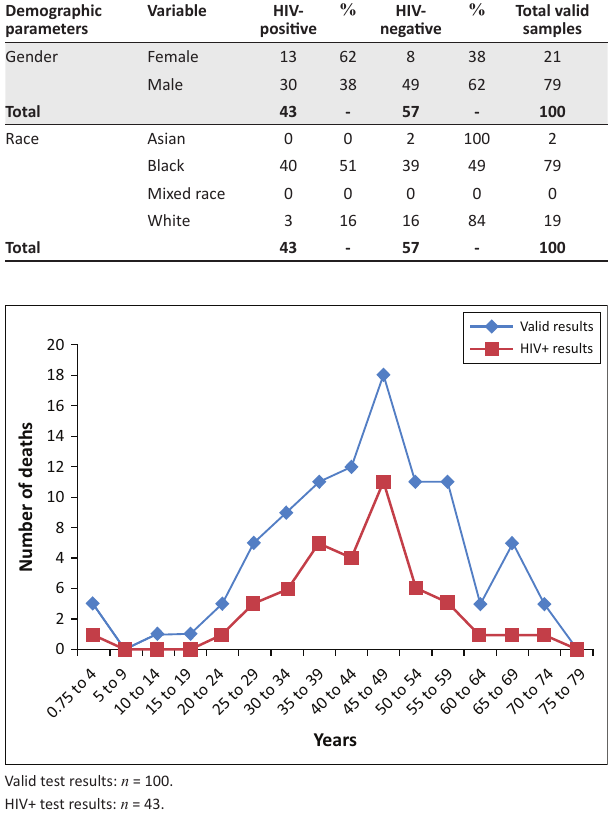
FIGURE 1: Age distribution of the valid sudden, unexplained and unexpected death samples and the HIV-positive results.